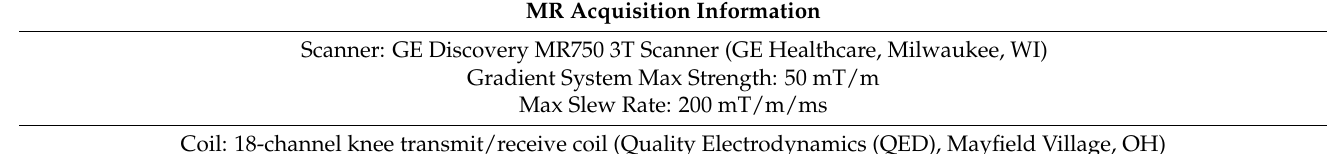
Table 1. Acquisition parameters for 3D fat-suppressed CUBE sequence used in K2S dataset, and for this challenge.